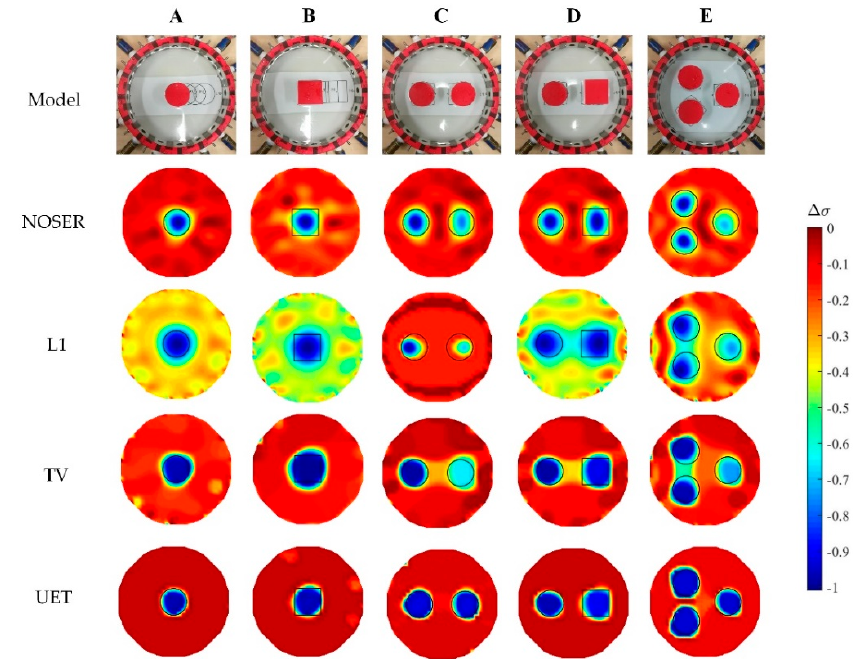
Figure 12. Reconstruction results of the experimental tests.